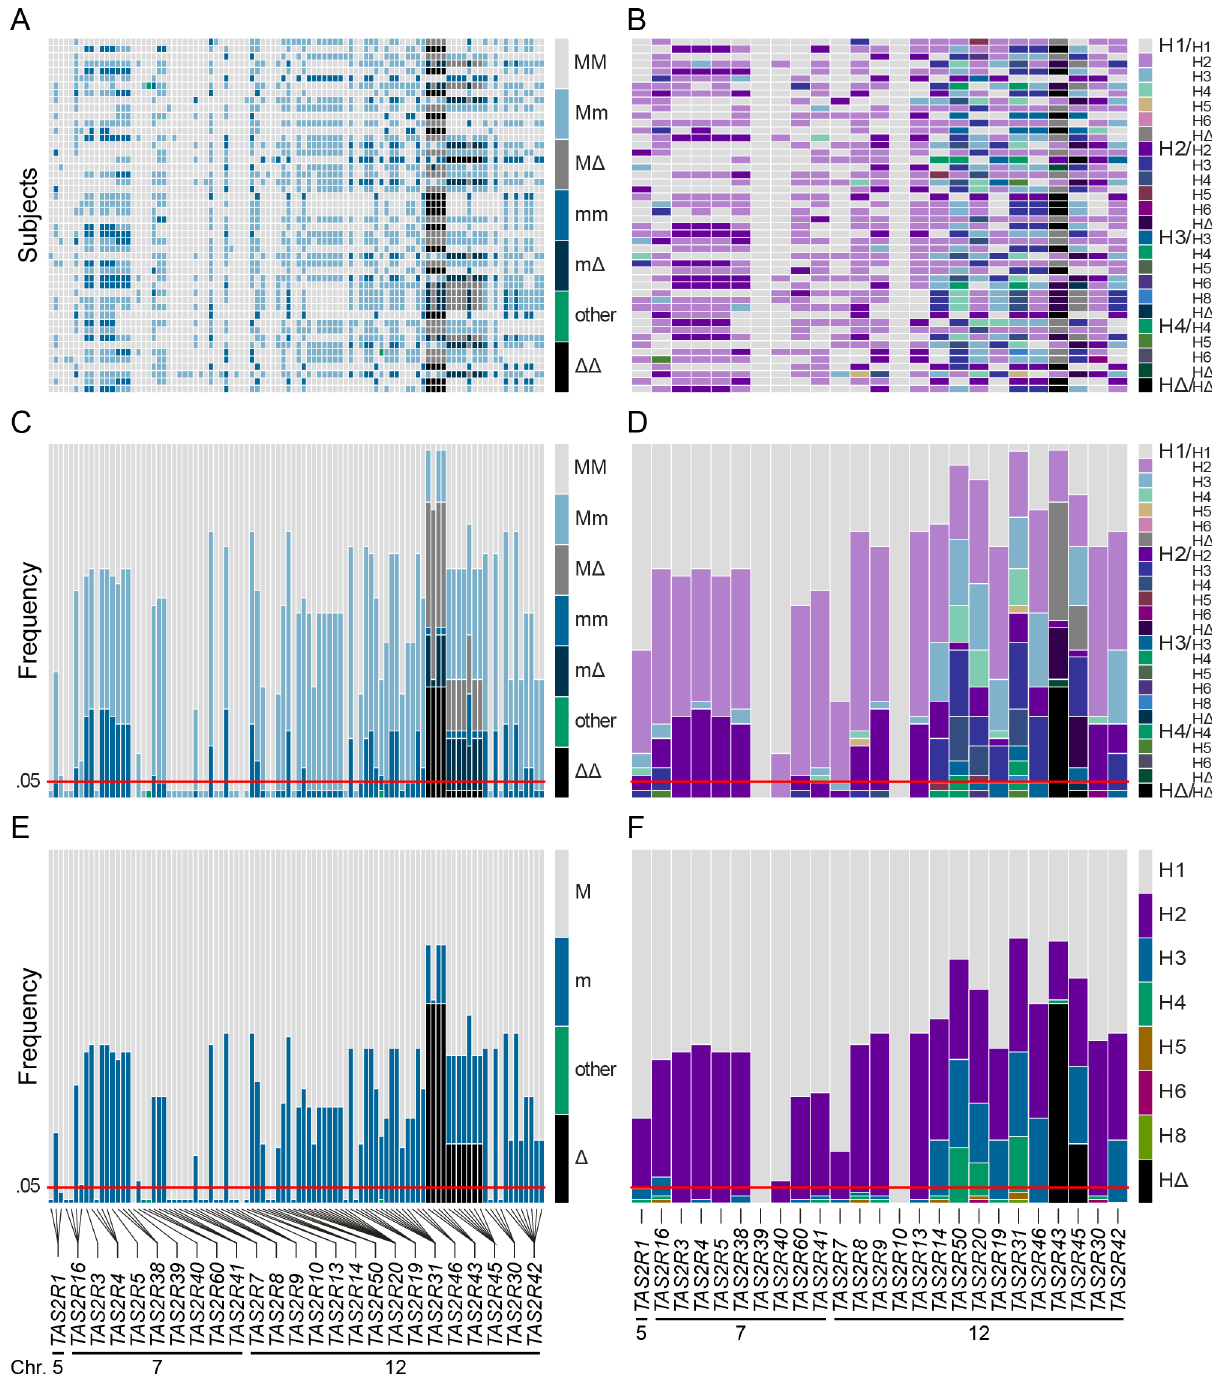
Fig 2. Coding region SNPs, genotypes and haplotypes of the 25 TAS2R genes. Light grey boxes indicate homozygous major genotypes or haplotypes, i.e., most common; black boxes, homozygous deleted genotypes or haplotypes, i.e., whole-gene deletion; each other colour box specifies a different genotype or haplotype, homozygous or heterozygous, as detailed in the colour bar. Haplotypes were named according to previous nomenclature or according to their respective allele frequencies in our subjects; the most common haplotypes receiving the smallest number [26]. Chromosomal assignments are specified for cSNPs and TAS2R loci. (A) cSNP genotypes by subject; (B) TAS2R genotypes by subject; (C) genotype frequency by cSNP site; (D) genotype frequency by TAS2R locus; (E) allele frequency by cSNP site; (F) haplotype frequency by TAS2R locus.